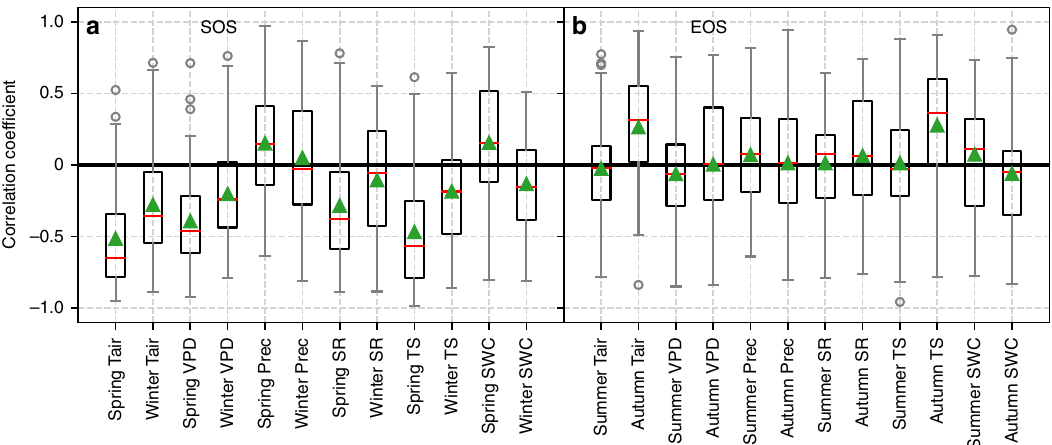
Fig. 3 Correlation coef fi cients between phenology (SOS and EOS) and environmental factors at the 56 FLUXNET sites. a Correlation coef fi cient between SOS and environmental factors in spring and winter. b Correlation coef fi cient between EOS and environmental factors in autumn and summer. The environmental factors are as follows: Tair air temperature, VPD vapor pressure de fi cit, Prec precipitation, SR shortwave downward radiation, TS soil temperature, SWC soil water content. For each box, the central red line is the median, the green triangle is the average, the upper and bottom edge of the box correspond to the 25th and 75th percentiles, the whiskers show the range of the data, and the gray circles are the